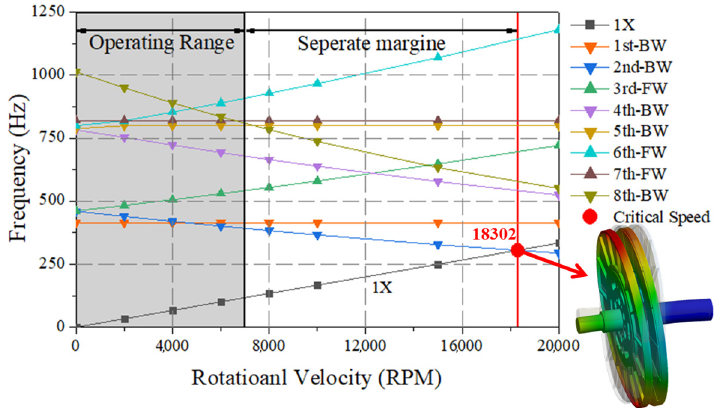
Figure 9. Result of the rotor critical speed analysis (Campbell diagram).